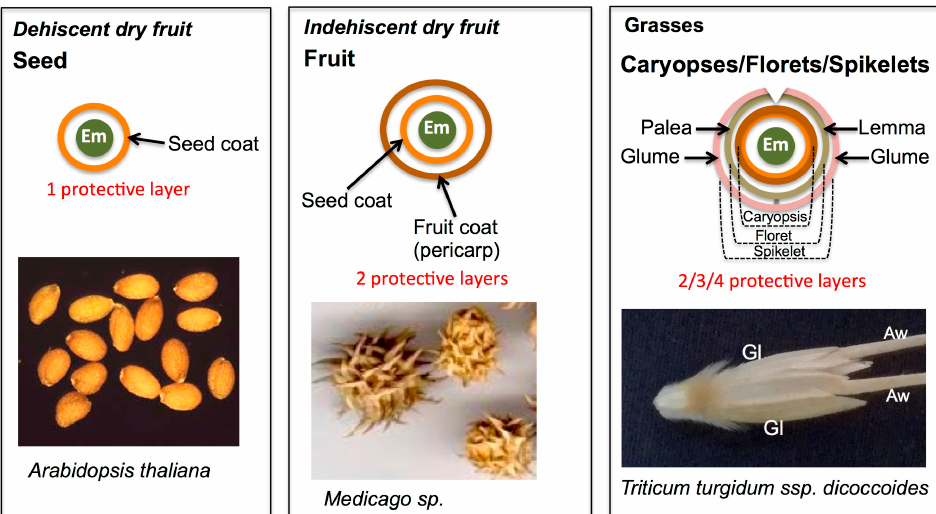
Figure 1. Dispersal units of dry fruits and grasses. Dry fruits can be either dehiscent, in which the fruit is opened at maturity to release the dispersal units, the seeds (e.g., Arabidopsis thaliana ), or indehiscent, whereby the fruit is not opened at maturity and represents the dispersal unit (e.g., Medicago species). In seed and fruit dispersal units, the embryo is covered by one and two protective layers, respectively. In grasses, the basic dispersal unit constitutes a unique type of dry fruit in which the seed coat and the pericarp are fused together to form the caryopsis. A floret is a type of dispersal unit, whereby the caryopsis is covered by the lemma and palea. In a spikelet, a floret or florets are further enclosed by glumes (e.g., Triticum turgidum ssp. dicoccoides ). Note, in caryopsis, floret and spikelet, the embryo is enclosed by two, three and four protective layers, respectively. Em, embryo; Gl, glume; Aw, awn (a long appendage at the lemma).